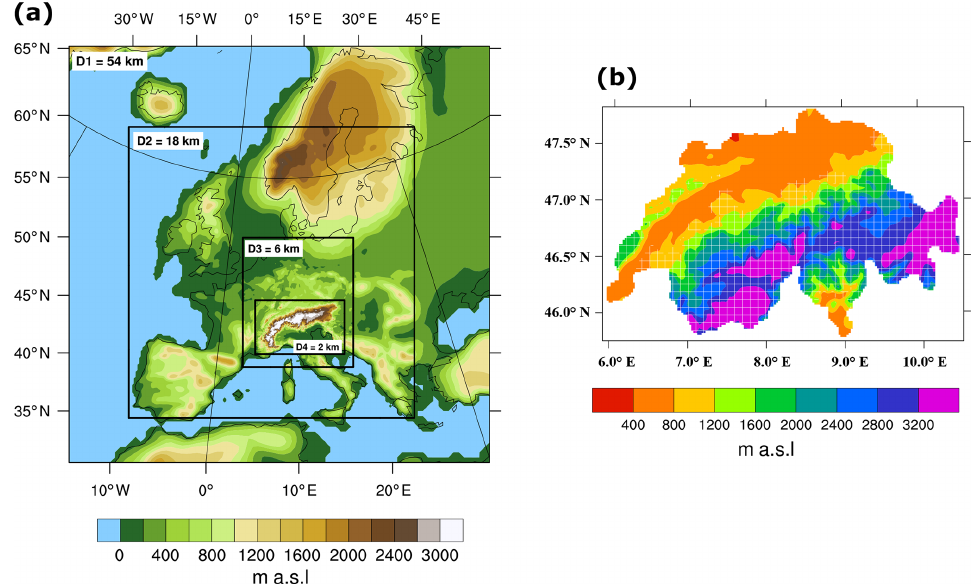
Figure 3. WRF domains and LGM topography. Panel (a) illustrates the LGM topography, LGM sea level, and the four domains used by WRF. Panel (b) indicates the height classes for the correction method (400m interval) using the LGM topography over Switzerland at 2km resolution; crosshatched areas are covered by glaciers.